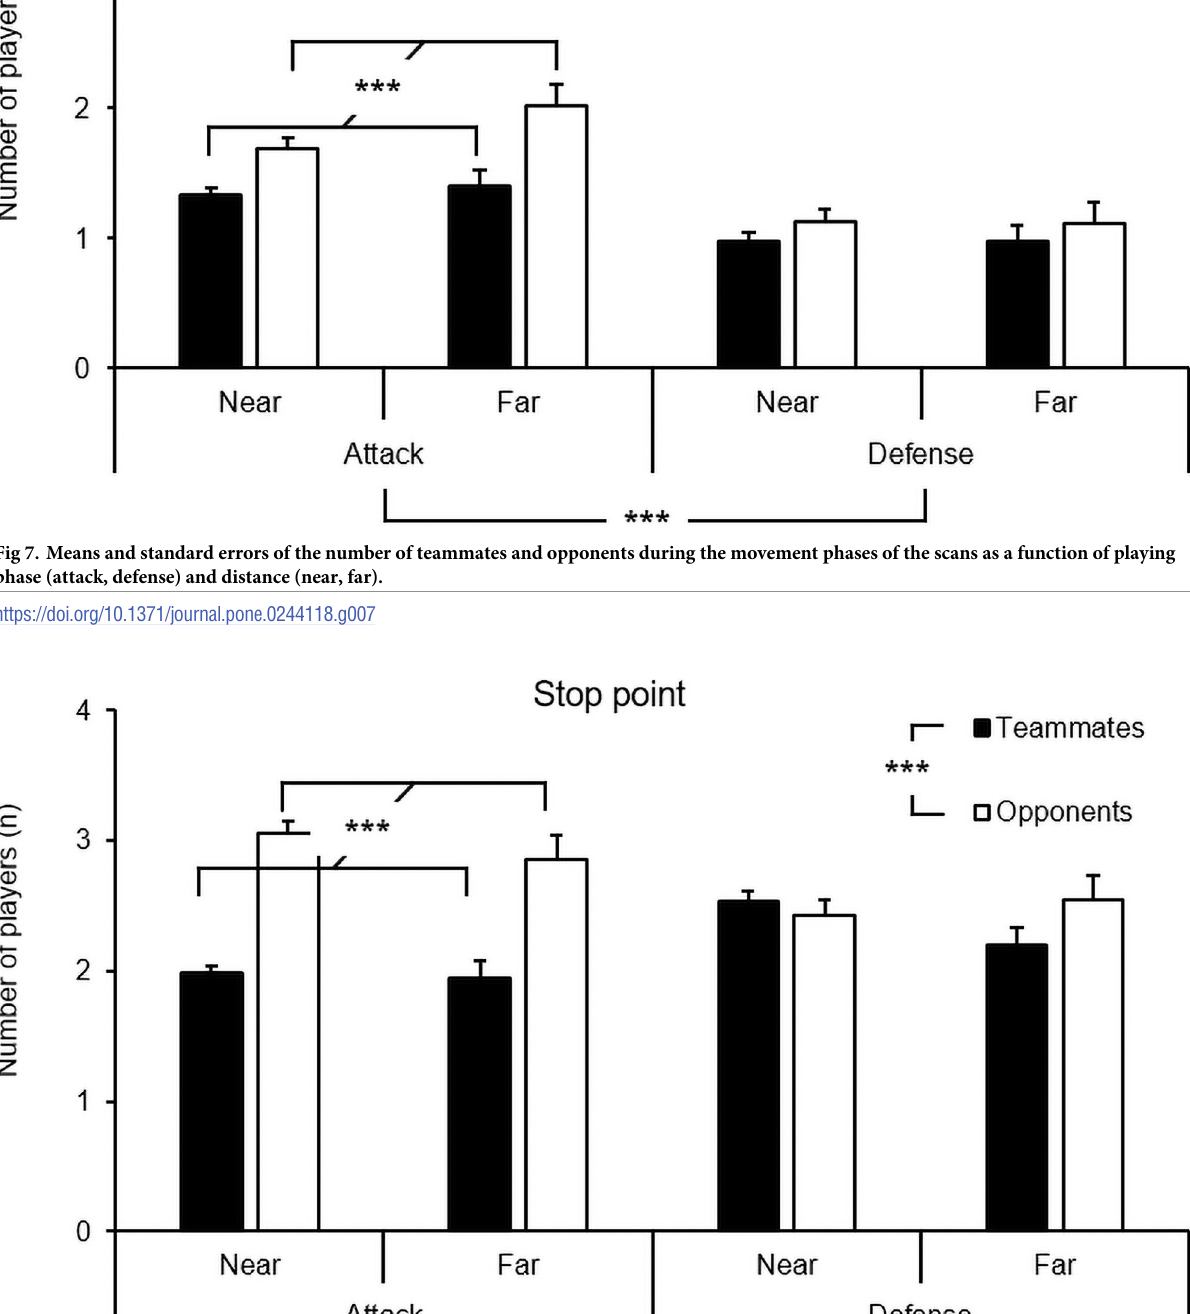
PLOS ONE | https://doi.org/10.1371/journal.pone.0244118 August 20, 2021 13 /